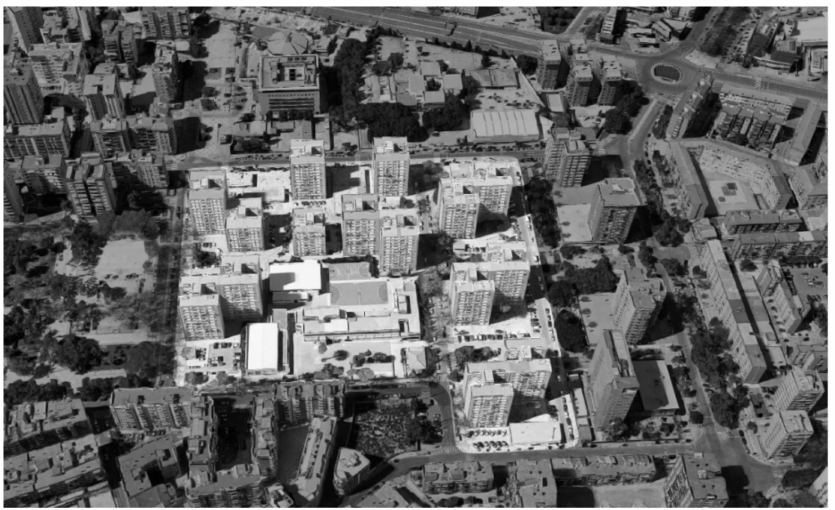
Figure 4. Aerial view of La Fama neighborhood (1961). Authors’ image based on Google Maps 3D